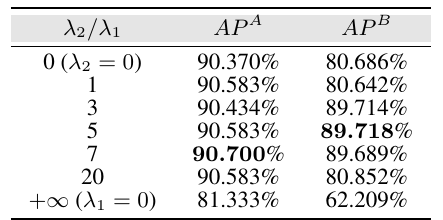
Table 4. The evaluation of the importance of the two parts of the new distance in the End Keypoint Clustering Algorithm on Dataset A and Dataset B through altering the ratio of λ 2 and λ 1